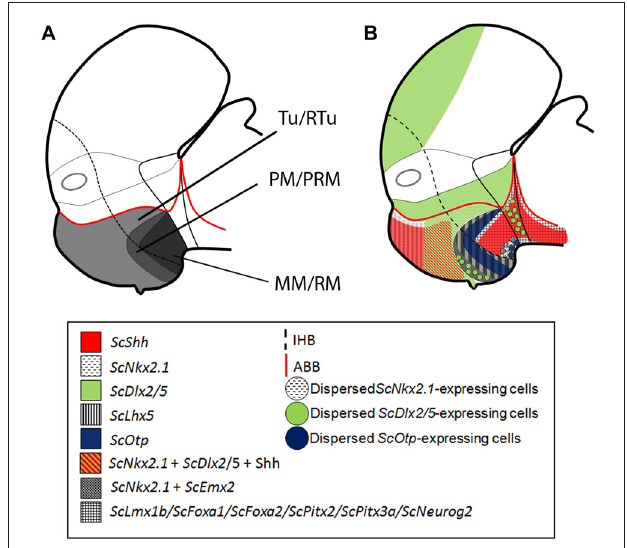
FIGURE 5 | Schematic representation of the catshark basal hypothalamus at mid development. For simplicity, the schemes do not represent medial (acroterminal) expression patterns. (A) Representation of prosomeric histogenetic domains Tu/RTu, PM/PRM, MM/RM based on Santos-Durán et al. (2015). (B) Genoarchitectonic organization based on current data. Different microzones are recognized into main histogenetic domains. For abbreviations, see